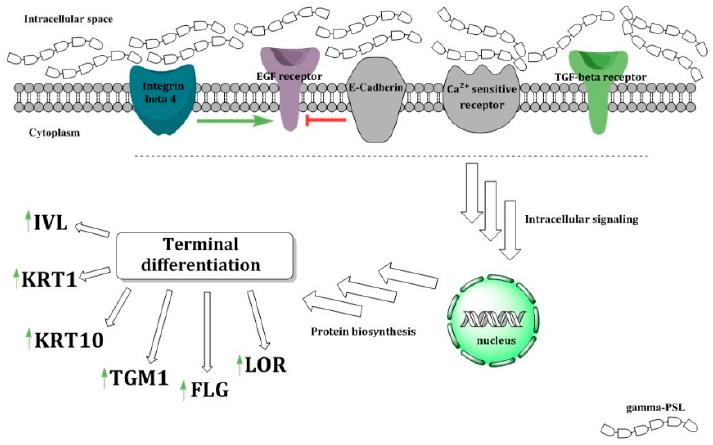
Figure 6. Potential mode of action of γ -PSL on NHEK, by interfering with the interaction of integrins on the cell surface with proliferation signals from the extracellular matrix.